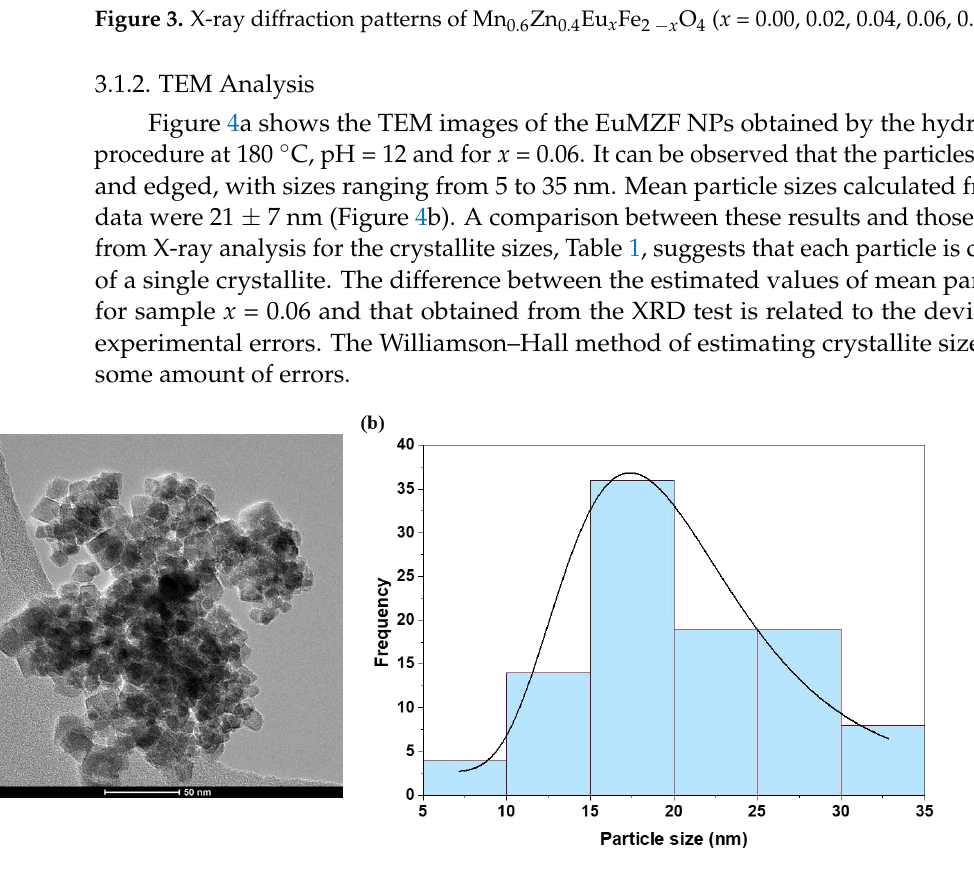
Figure 4. ( a ) TEM image of the sample x = 0.06 and ( b ) corresponding histogram of the particle size distribution.